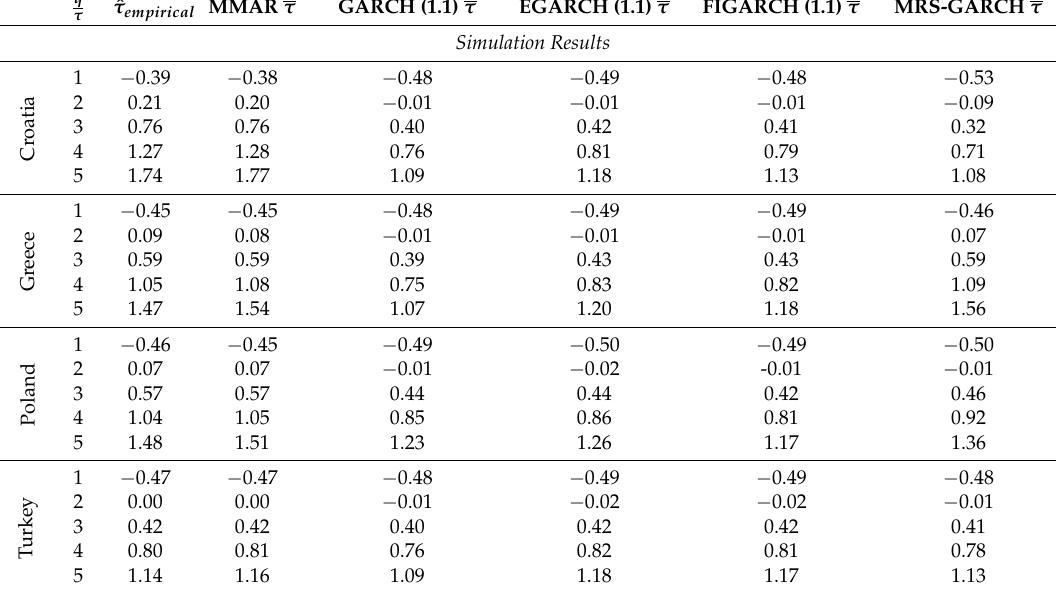
Table 10. Scaling function values of the empirical and simulated series.